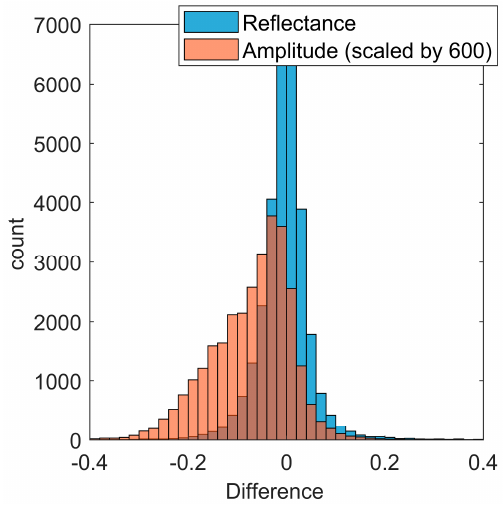
Figure 8. Calibrated reflectance map showing locations of spot comparisons. Point 1: Modern quarry strip. Point 2: Asphalt road. Visualization: 1 m spatial resolution raster calculated using the median value of each cell. Coordinate system: WGS84 UTM Zone 33N.